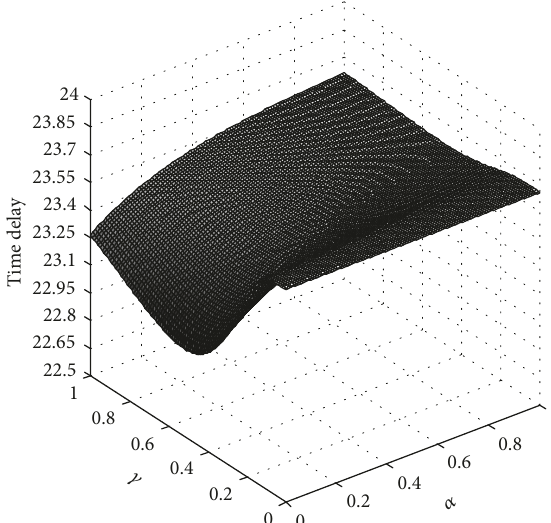
Figure 18: The influence of time delay caused by 𝛼 and 𝛾 .